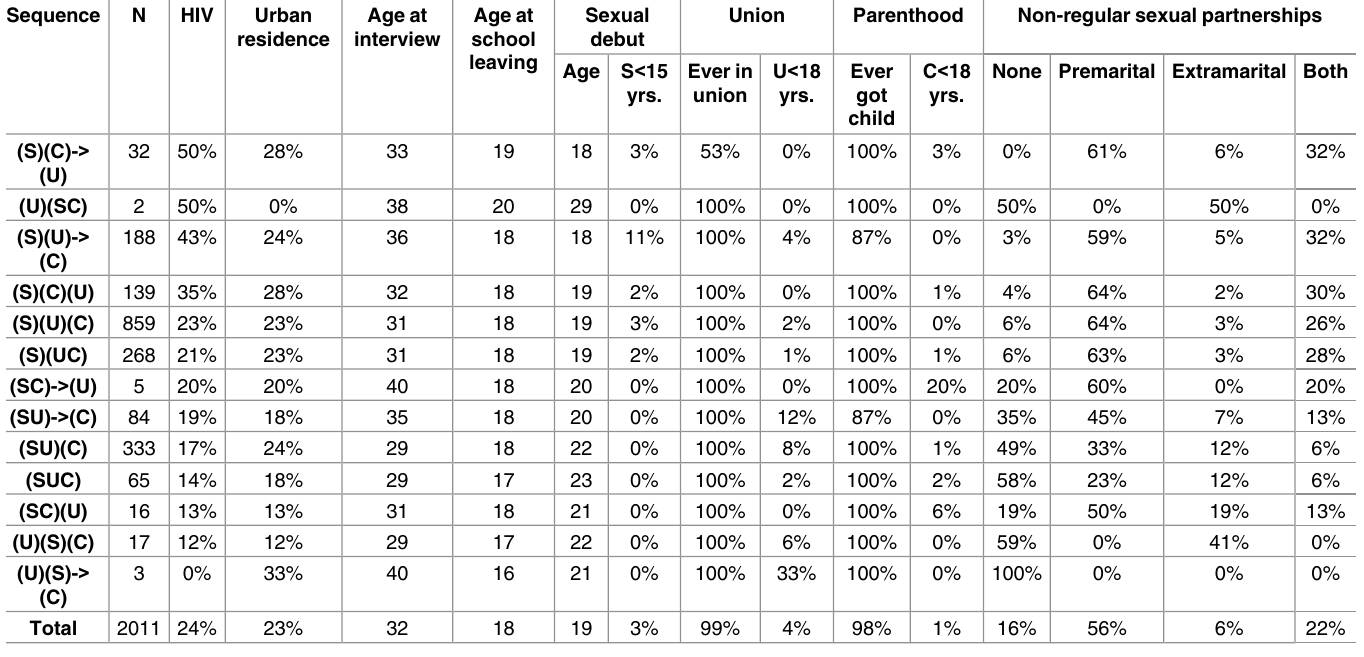
Table 2. Characteristics of men included in the sample. Descriptivestatistics on socio-demographicand sexual behaviourcharacteristics for men, strat- ified by sequence, and overall, Manicaland (Zimbabwe), 2000–2011. Sequences are sorted in descendingorder by HIV prevalence. Sequence N HIV Urban